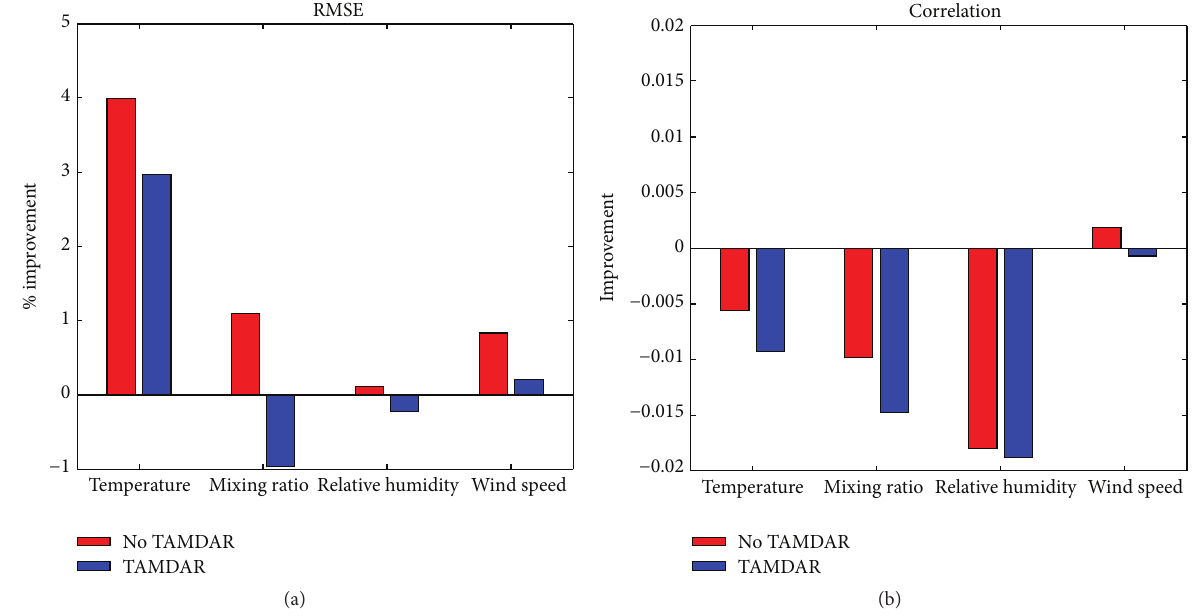
Figure 4: (a) Percentage improvements for root mean squared error (RMSE) and (b) correlation improvement for temperature, mixing ratio, relative humidity, and wind speed due to the resolution increase (without TAMDAR data: red bars; with TAMDAR data: blue bars). The abscissa represents the variables while the ordinate represents the improvement. The statistics are averaged over all sounding locations, vertical levels, and the 6-day (August 1 through August 6) simulation